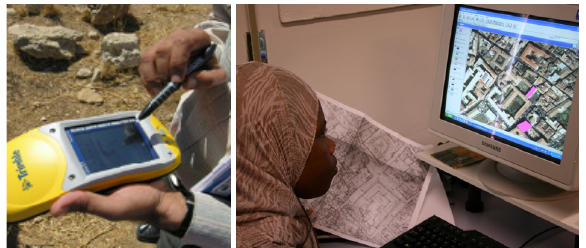
Figure 6 and 7. Training in the use of GIS during the GCI- WMF training initiative in Jordan in 2005 (left) and during the ICCROM-GCI ARIS Course in 2007